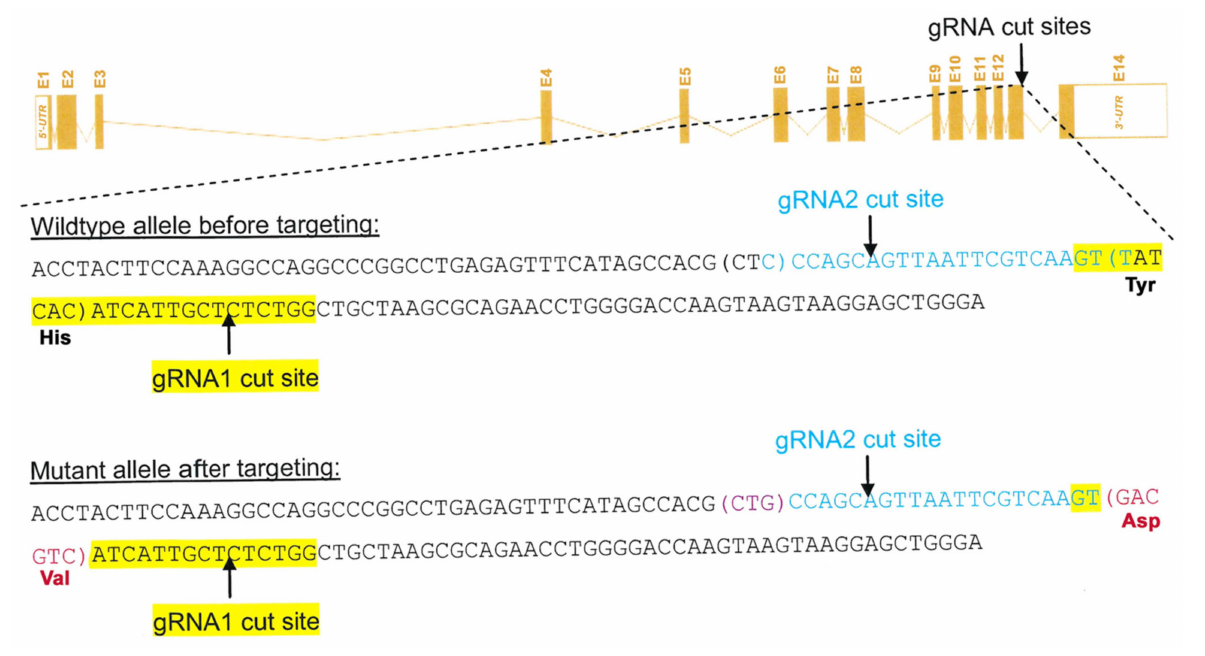
Figure 1. Crispr/Cas9 strategy for creating Alox15b-KI mice. To create Alox15b -KI mice, we employed the Crispr/Cas9 strategy to introduce the Tyr603Asp + His604Val double mutant into the wildtype Alox15b gene. The resulting knock-in mice express the AA 15-lipoxygenating Tyr603Asp + His604Val double mutant instead of the AA 8-lipoxygenating wildtype enzyme. For this purpose, the donor oligonucleotide (TAT-CAC to GAC-GTC) was introduced into exon 13 by homology-directed repair mechanisms. In addition, a silent mutation (CTC to CTG) was introduced.